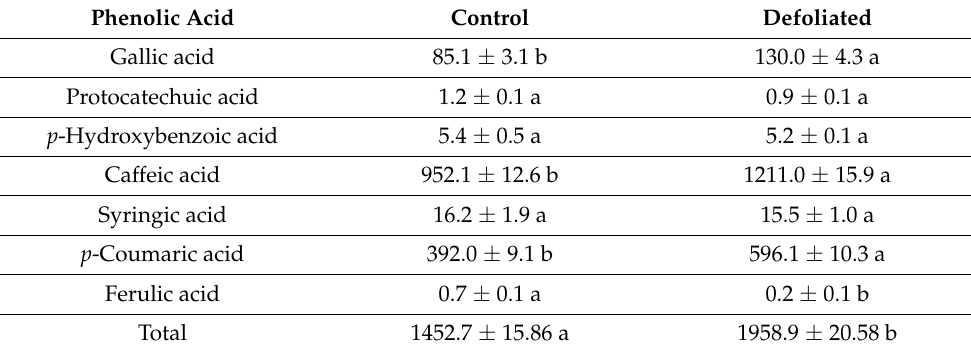
Table 2. Conjugated phenolic acids ( µ g g − 1 fresh weight) in grape berries from control and defoliated vines of Vitis vinifera (Trebbiano varieties). Data are reported as mean values ± standard error. For each compound means accompanied by different letters are significantly different at p ≤ 0.05.